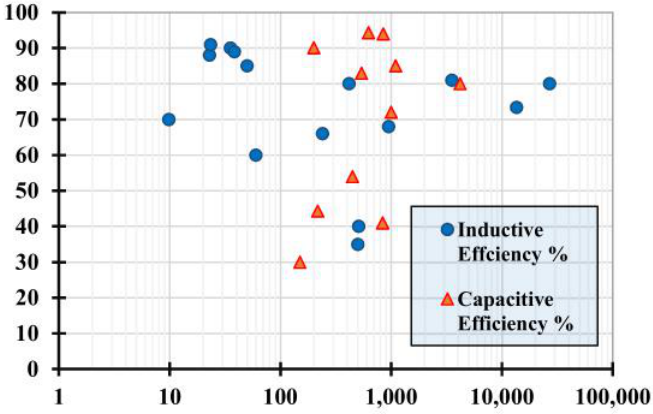
Figure 5. Graph of EFFICIENCY (inductive, capacitive) vs. FREQUENCY (in x